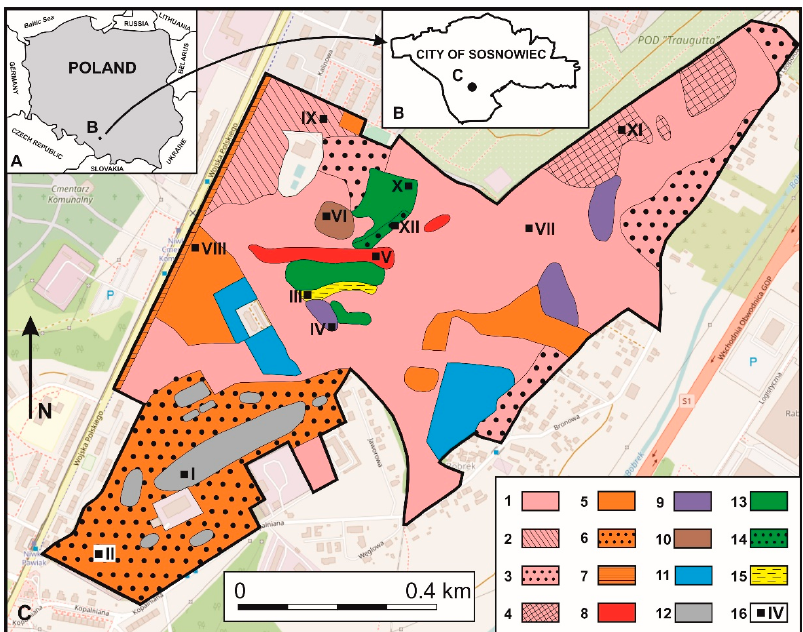
Figure 1. Distribution of vegetation and soil sampling sites: (1) Artificial birch stand (urban park); (2) Betula pendula stand; (3) Populus-Betula stands, (4) Quercus-Pinus stand; (5) Robinia pseudoacacia stand; (6) Calamagrostietum epigeji ; (7) Thickets of R. pseudoacacia ; (8) Juncus effusus community; (9) Alder community; (10) Ulmus-Quercus stands; (11) Arctio-Artemisietum vulgaris ; (12) Rudbeckio-Solidaginetium ; (13) Pinus sylvestris stand; (14) Quercus-Pinus stand; (15) Populus-Alder-Salix stand, (16) Soil sampling places (I–XII). Source: by authors on the base of: OpenStreetMap.org,